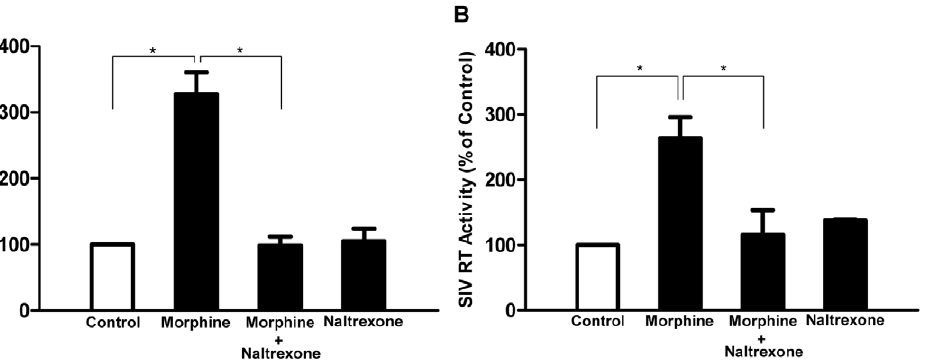
Figure 1. Morphine enhances HIV Bal strain (A) and SIV Delta B670 strain (B) infection of macrophages. Seven-day-cultured macrophages were incubated with or without morphine (10 2 10 M) for 24 h before HIV or SIV infection. An opioid receptor antagonist, naltrexone (10 2 8 M) was added to macrophage cultures 1 h before morphine (10 2 10 M) treatment. HIV or SIV RT activity in culture supernatant was determined at day 6 postinfection. Data are expressed as HIV (A) and SIV (B) RT activity in morphine-treated cells (percentage of control) to those in untreated cells, morphine-treated cells plus naltrexone versus morphine only. The results represent the mean 6 SD of three experiments using cells from three different donors. Statistical analysis was performed using one-way analysis of variance, and significance is shown with * P , 0.05 (morphine vs control or morphine vs morphine + naltrexone).